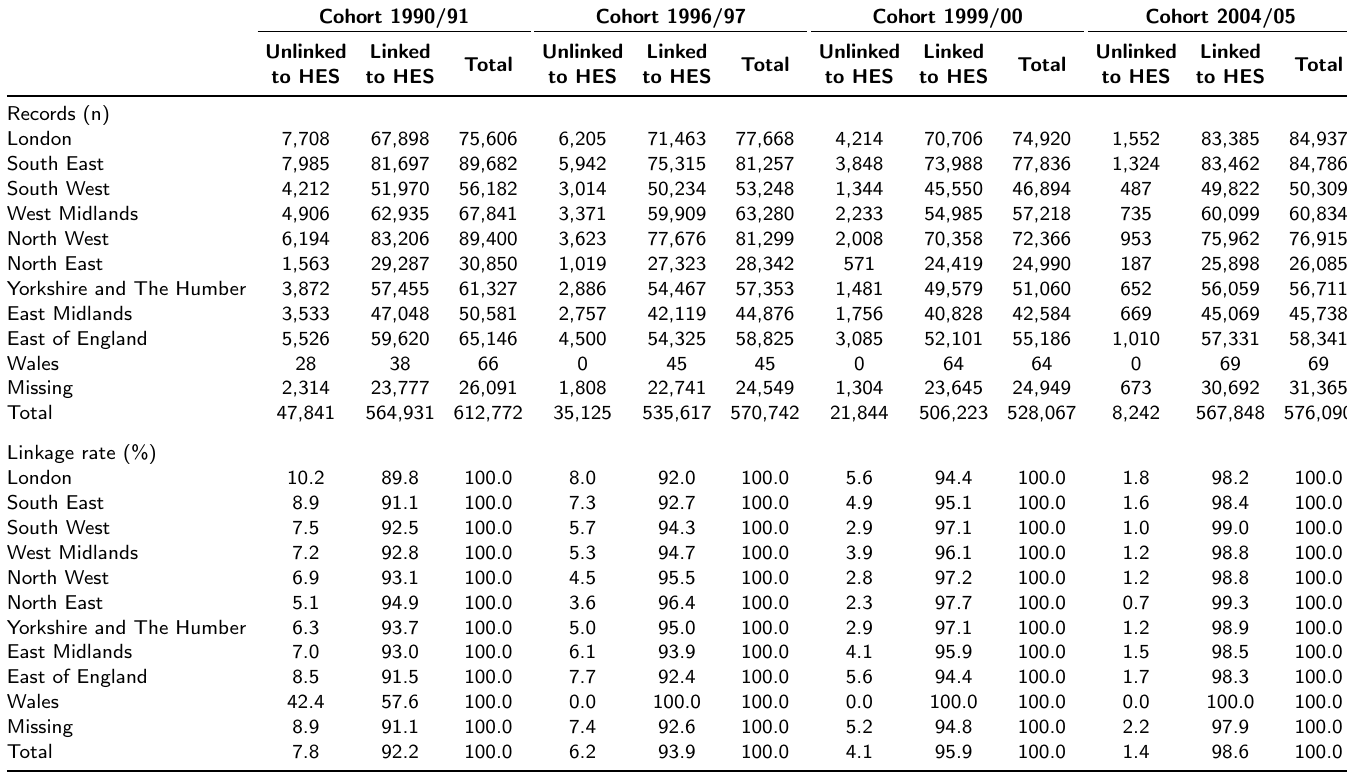
Supplementary Table 8.1: Linking rate by region 2011 pupil’s residence (first recorded) and cohort